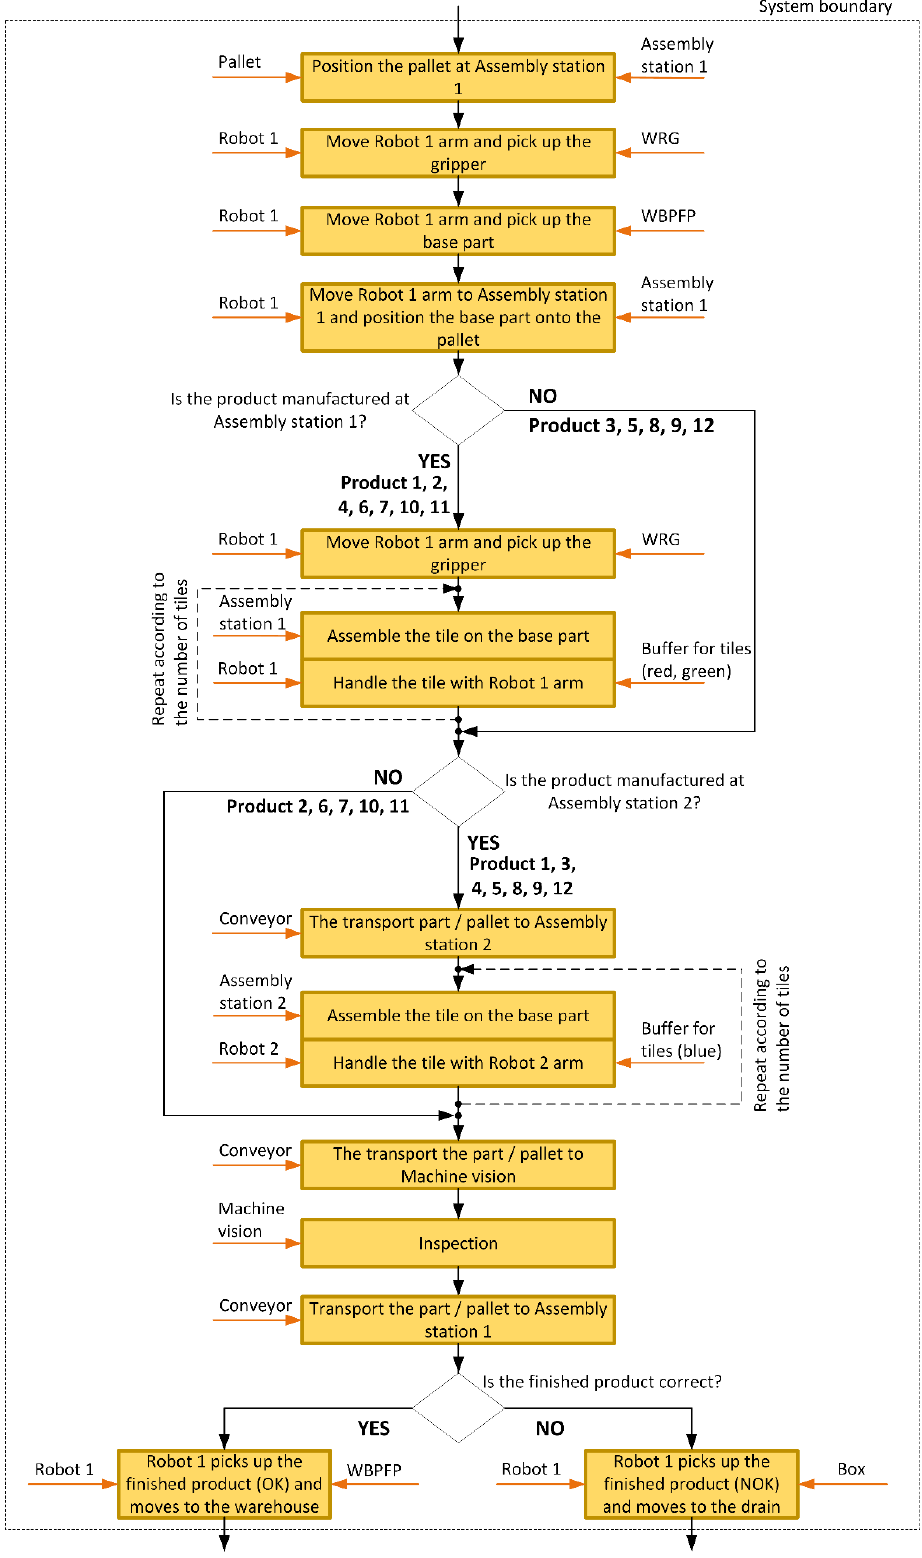
Figure 12. The sequence of processes in the manufacturing system case study.